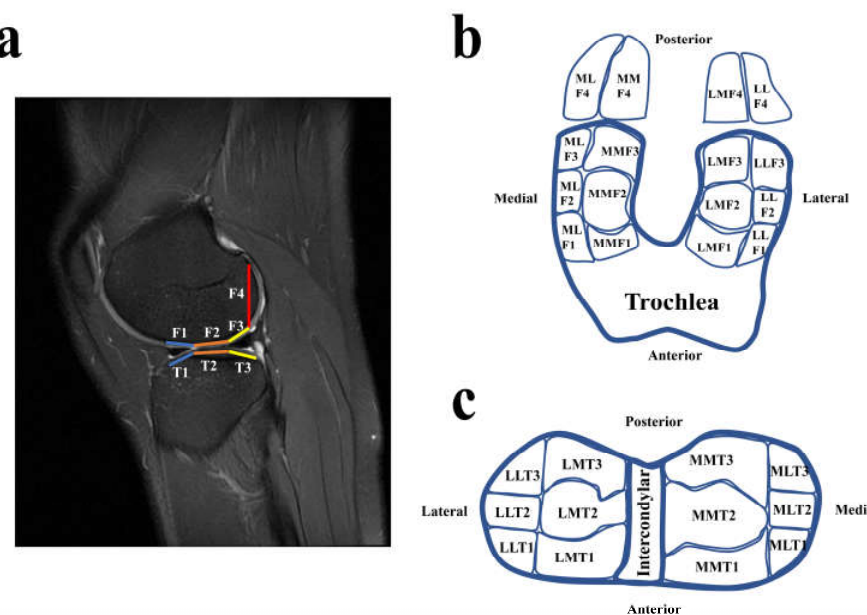
Figure 2. Diagram of the subregions of cartilage in the tibiofemoral joint. ( a ) Diagram of the sagittal plane of the subareas; ( b , c ) diagrams of the subareas of the femoral condyles. In the abbreviations used for the subareas of the femoral condyles and tibia plateau, the first letter represents the compartment (M for the medial compartment and L for the lateral compartments). The second letter represents the side of the compartment (M for the medial side and L for the lateral side). The third letter represents the condyle or plateau (F for femoral condyle and T for tibial plateau). The final number represents the area marked on Chart ( a ) (1 for anterior, 2 for middle, 3 for posterior, and 4 for superoposterior).